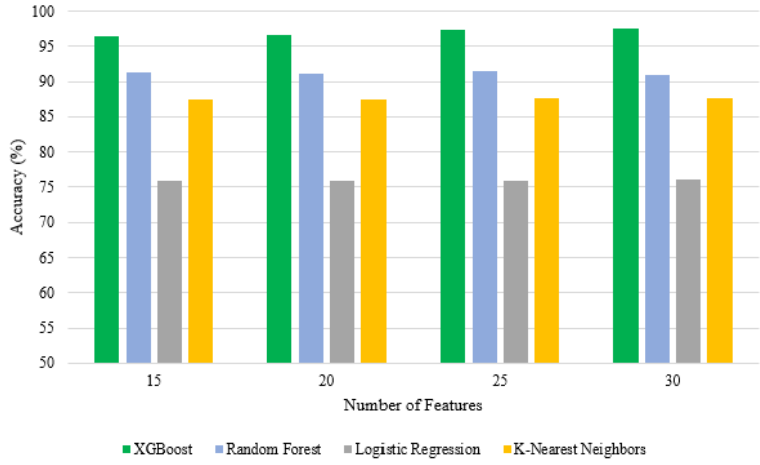
Figure 9. Accuracy comparison for the top features selected by chi-square.